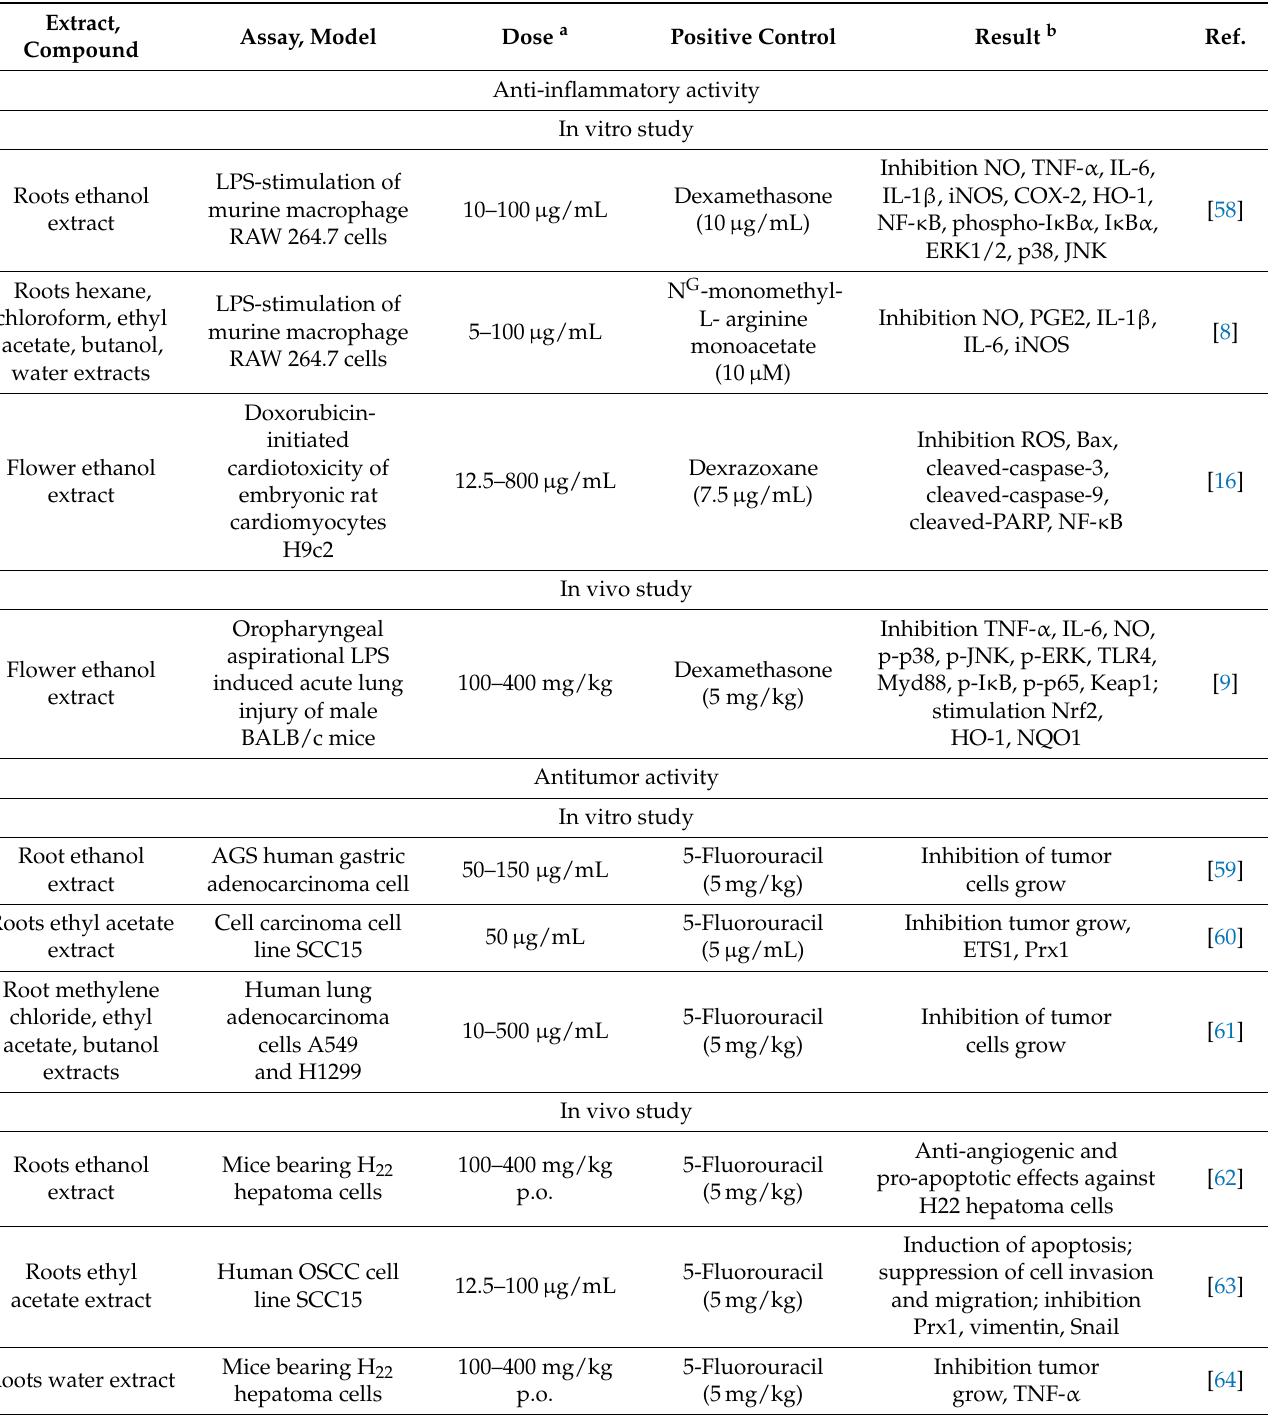
Table 5. Bioactivity data of R. uniflorum